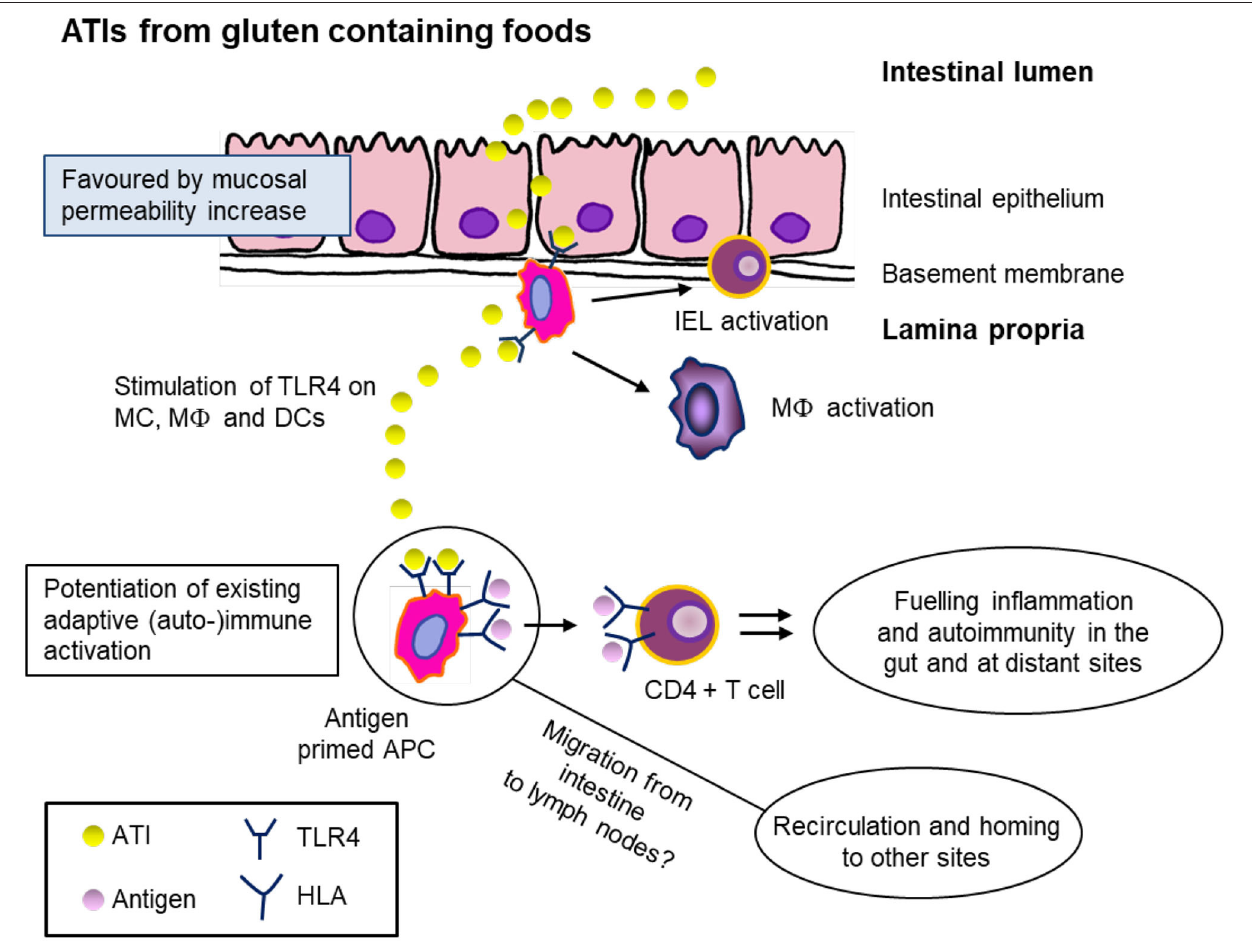
FIGURE 4 | Hypothetical mechanism of ATI bioactivity as innate triggers of intestinal and extraintestinal immune activation after ingestion of gluten containing foods (e.g., wheat, spelt, rye, and barley). ATIs pass the intestinal epithelium as intact proteins and stimulate the toll-like receptor 4 (TLR4) on monocytes (MC), macrophages (M 8 ), and dendritic cells (DC). This leads to potentiation of existing adaptive immune activation and an increase of antigen-presenting cells (APC). These serve as adjuvants for an ongoing adaptive T-cell response and intensify chronic and autoimmune diseases. It is supposed that the APC occur at extraintestinal sites, e.g., mesenteric lymph nodes. IEL, intraepithelial lymphocyte; HLA, human leukocyte antigen. Figure modified from Schuppan et al. (